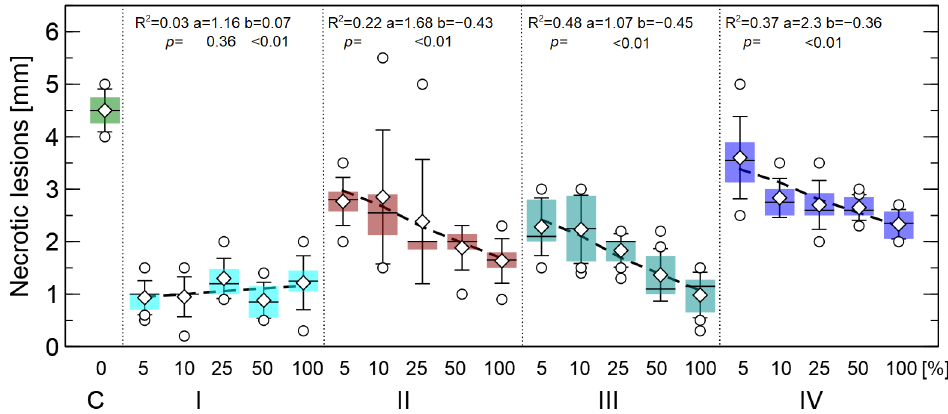
Figure 6. The relation between necrosis length and concentration of the applied extracts in treatments I–IV. Only samples, to which Ganoderma applanatum and Trametes versicolor were applied are shown here. C refers here to Control treatment, for which no extracts were applied. The dashed lines represent fitted regression lines y = a + b · ln ( x ) . The R 2 of the models, regression coefficients and corresponding p -values are typed in